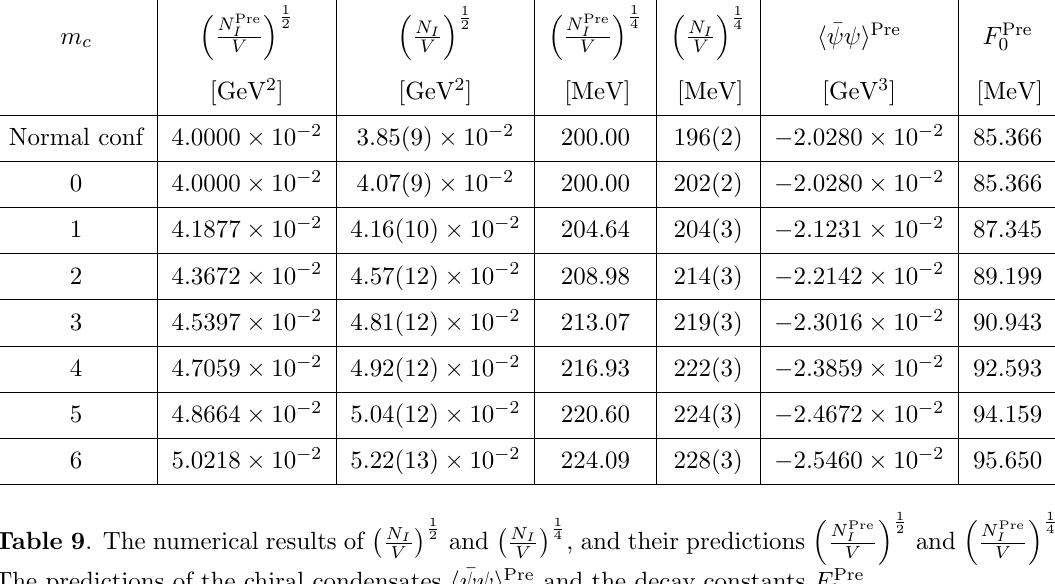
Table 9 . The numerical results of The predictions of the chiral condensates h (cid:22) i Pre and the decay constants F Pre